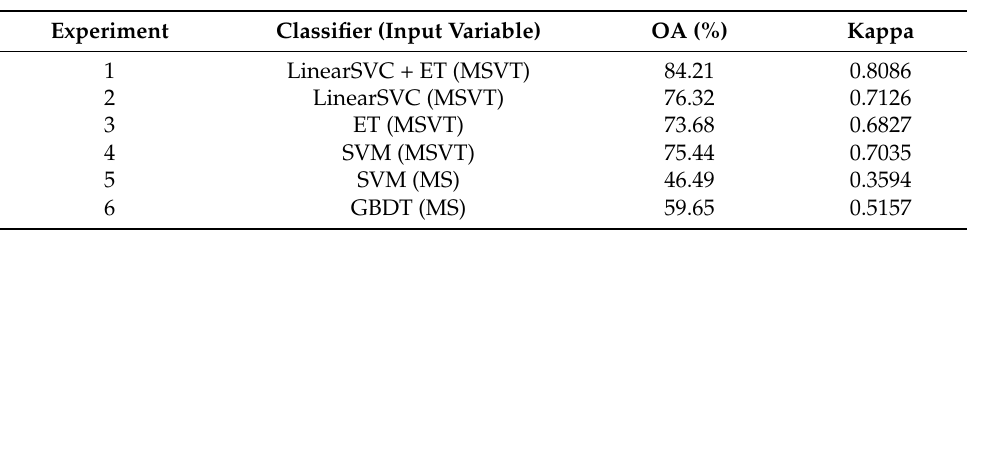
Table 7. OA and Kappa of the six